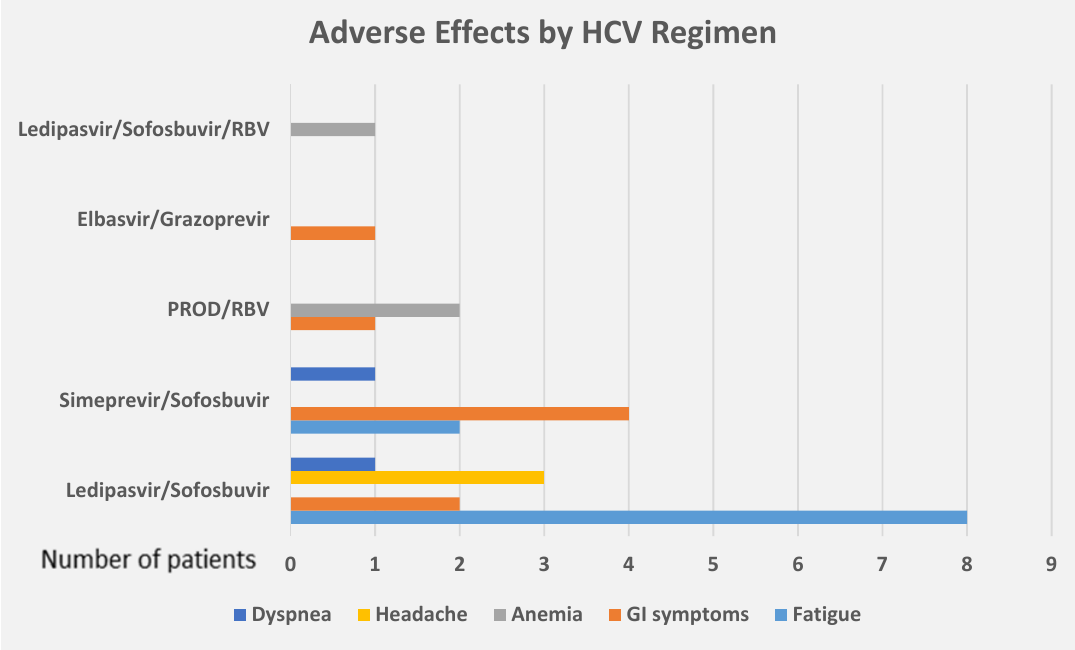
Figure 1. Adverse effects of DAA by the regimen of HCV treatment. PROD = Paritaprevir/ritonavir/ombitasvir/dasabuvir, RBV = Ribavirin, GI = Gastrointestinal.